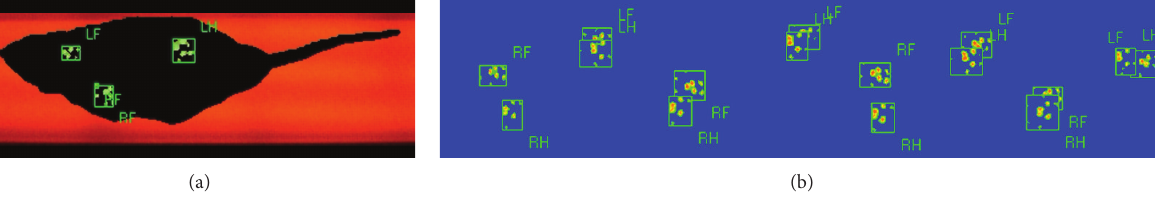
Figure 1: Screen shots represent the Catwalk gait analysis method. (a) A rat, running on the platform. (b) Representation of paw prints in the analysis software. RF: right front paw; LF: left front paw; RH: right hind paw; LH: left hind